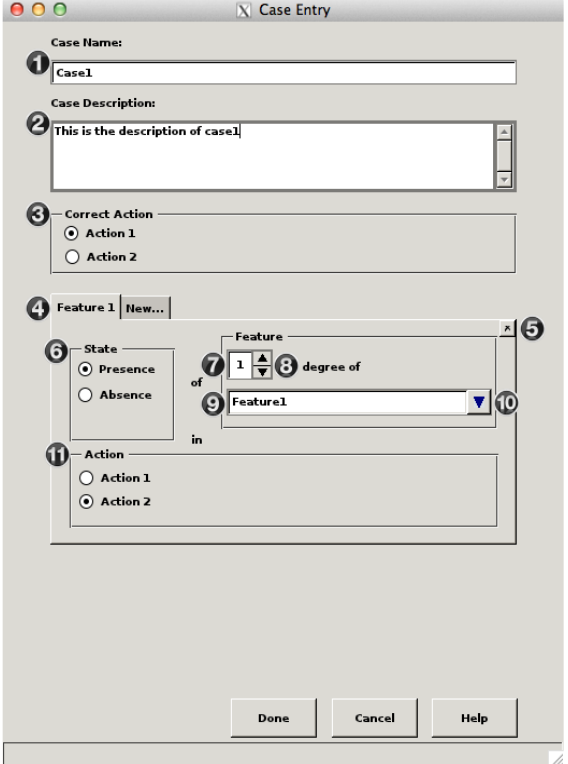
Figure 2 GenEth’s case entry dialogue used to enter information concerning each case of the dilemma type in question.